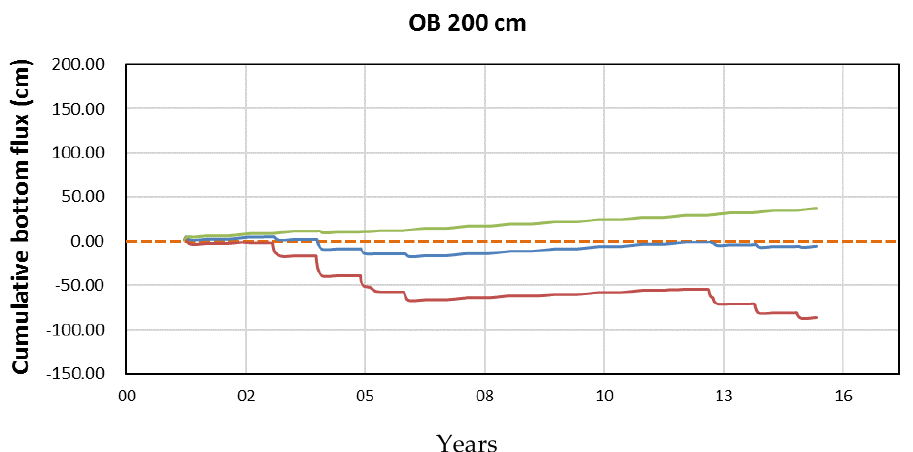
Figure 11. Cumulative water fluxes at the lower boundary of soil profiles under different capping strategies and climate conditions (blue line, normal condition; red line, wet condition; green line, dry condition. The line above zero indicates a net groundwater up-flux, and the line below zero indicates a net discharge of soil water to groundwater).